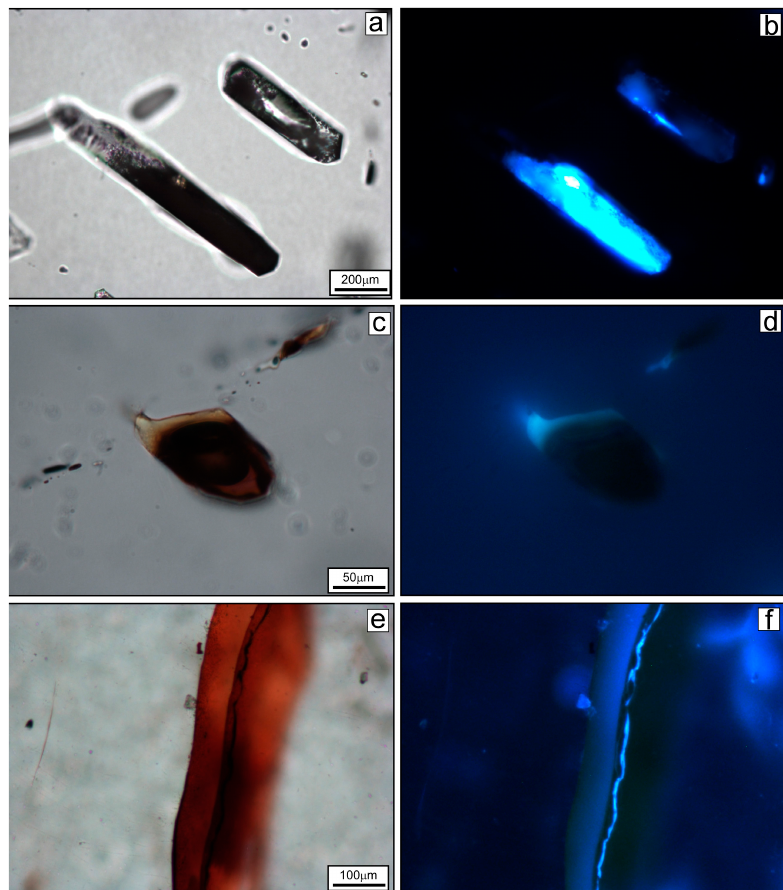
Figure 4. Photomicrographs of Type 2, Type 3 and an amber coloured oil-filled fracture spatially related to Type 3 all showing blue fluorescence under ultraviolet (UV) light. ( a ) Two large Type 2 inclusions in transmitted plane polarised light (TPPL) and ( b ) same view under UV light; ( c ) Amber coloured oil-bearing two-phase Type 3 inclusion in TPPL and ( d ) same view under UV light; ( e ) An amber coloured oil-filled fracture and ( f ) same view under UV light.